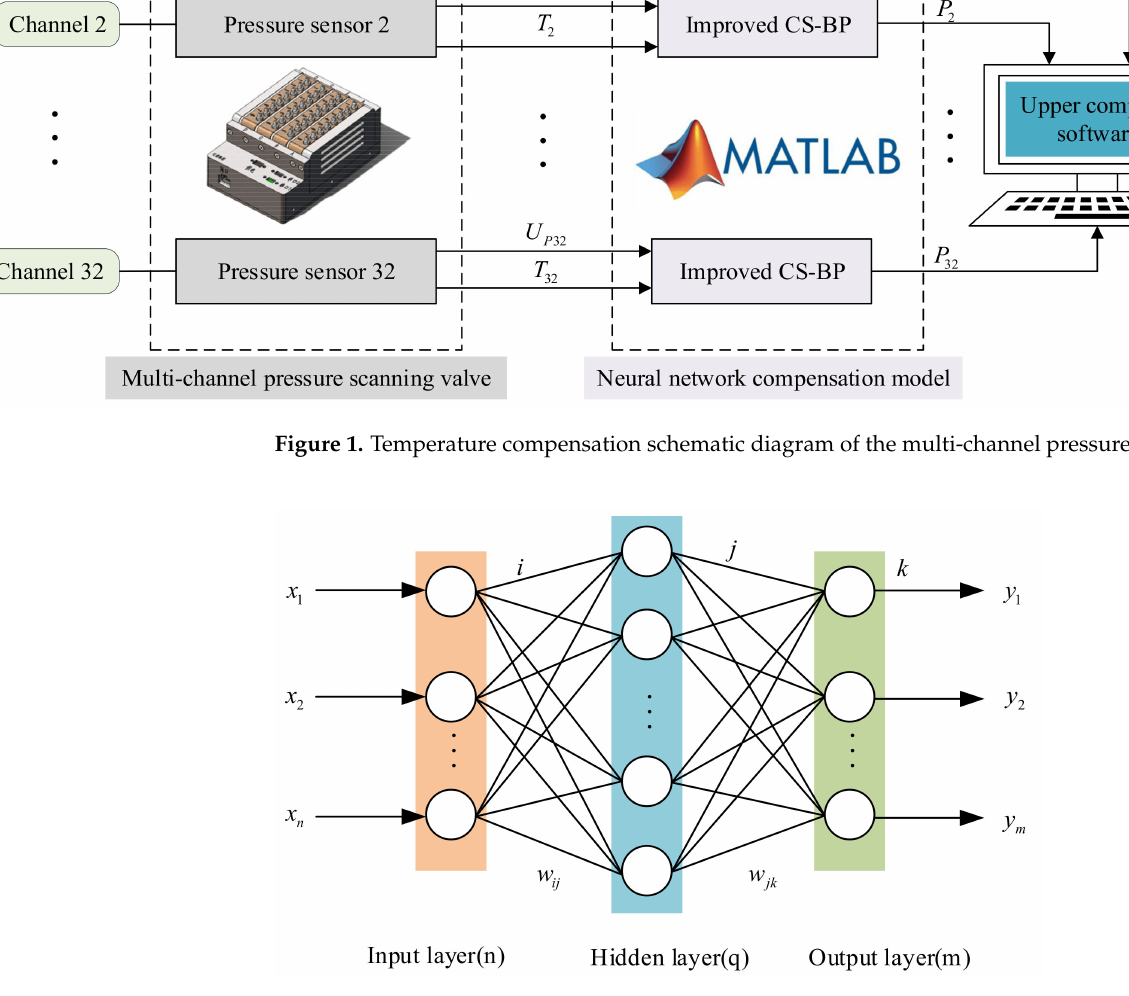
Figure 2. Structure diagram of BP neural